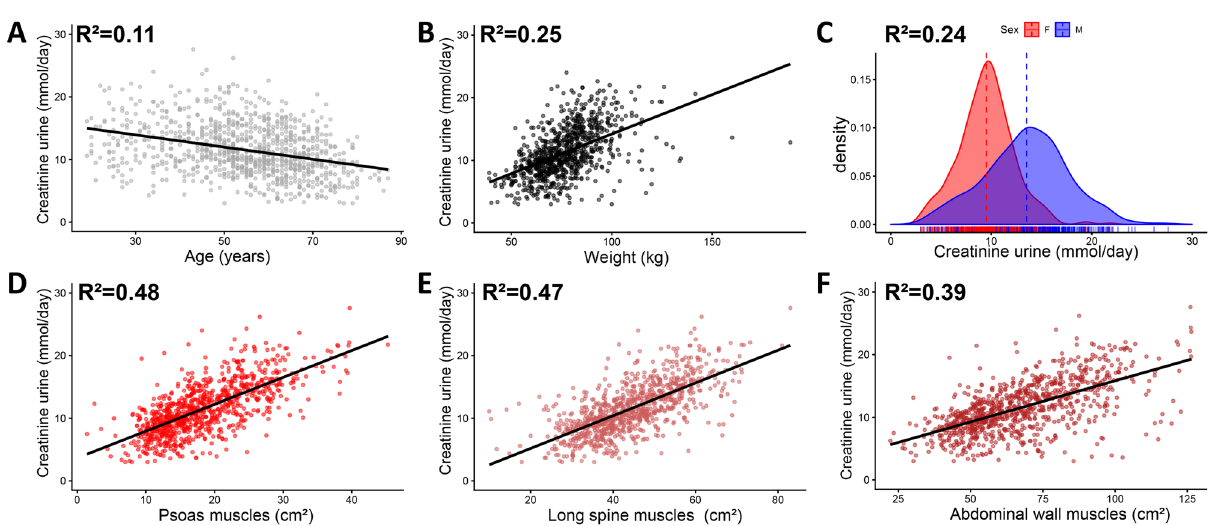
Figure 1. Examples of segmentation by the algorithm in a patient with average ( A ), obese ( B ), and cachectic ( C ) body composition. Red is subcutaneous fat, green is visceral fat, blue are the psoas muscles, purple are the long spine muscles and orange are the abdominal wall muscles.